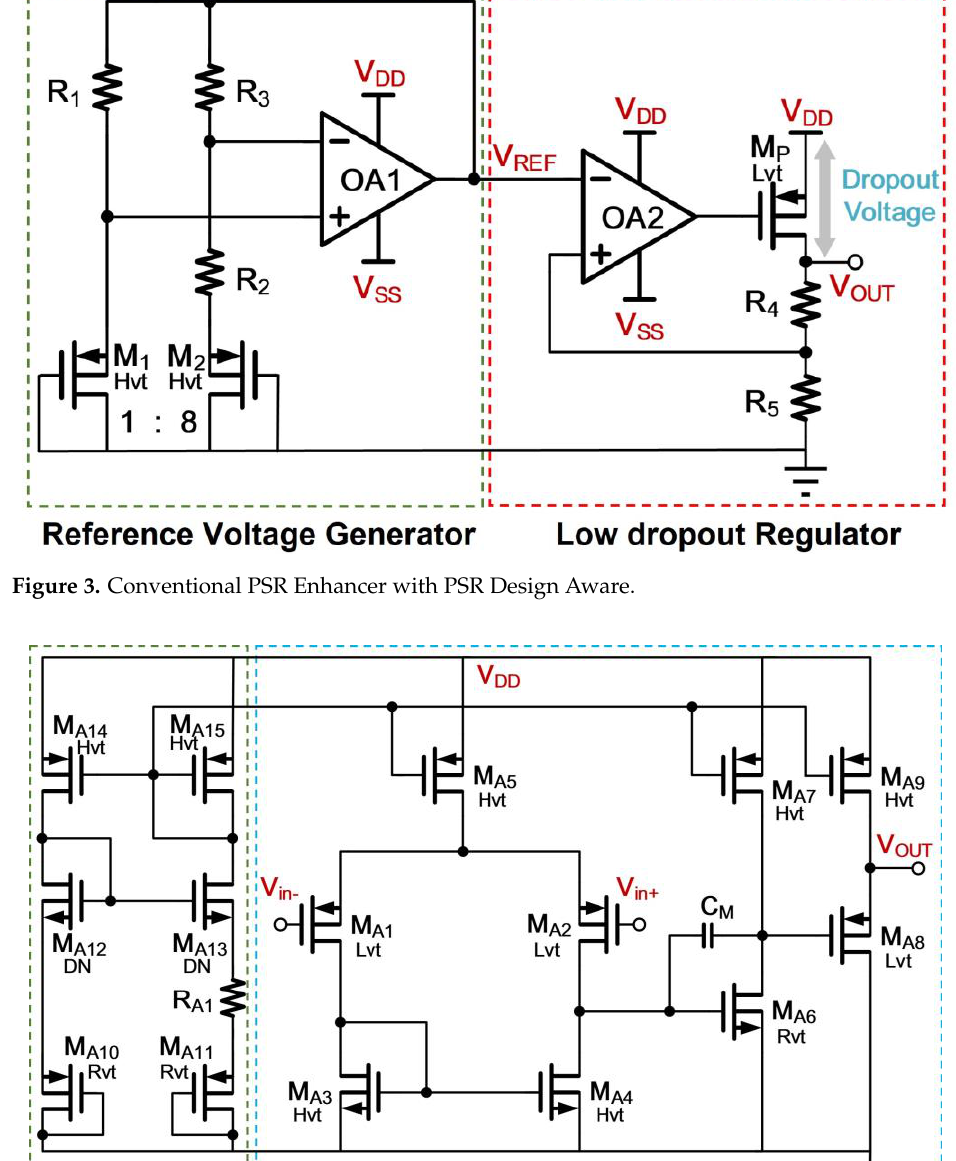
Figure 4. Schematic of OA 1 for Reference Voltage Generator in Enhancer.